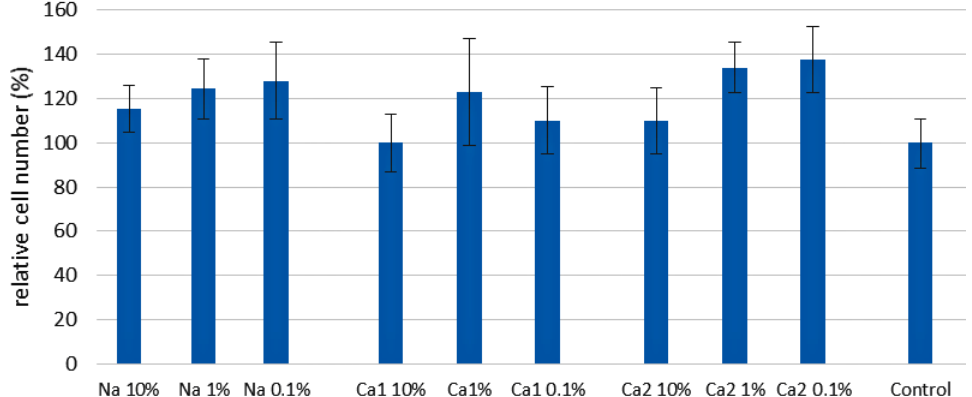
Figure 10. The results of 7-day cell adhesion and proliferation experiments for the solutions of PEPA metal salts diluted by the factors of 1000, 100 and 10. The starting solutions of the salts were prepared in phosphate/metal molar ratios of 1:1 (Na-PEP, Ca1-PEP) and 2:1 (Ca2-PEP). The initial concentration of phosphate groups was 0.443 mmol/g. The percentage of the cell viability relative to control (additive-free plates) is presented. Reprinted with permission from [125]. Copyright (2019) MDPI.